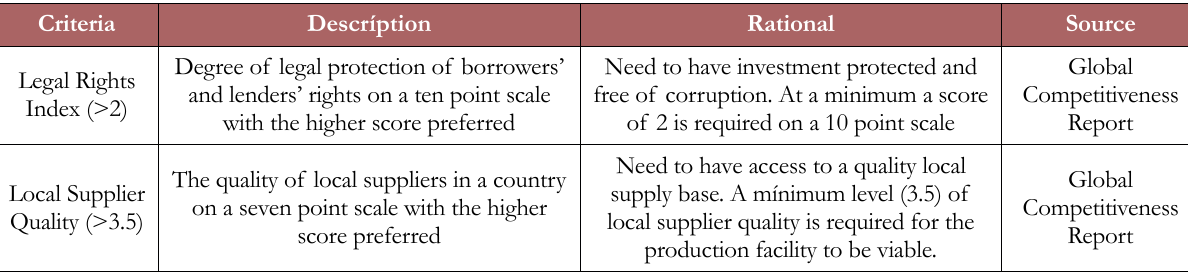
Table 11. Location attractiveness model must haves